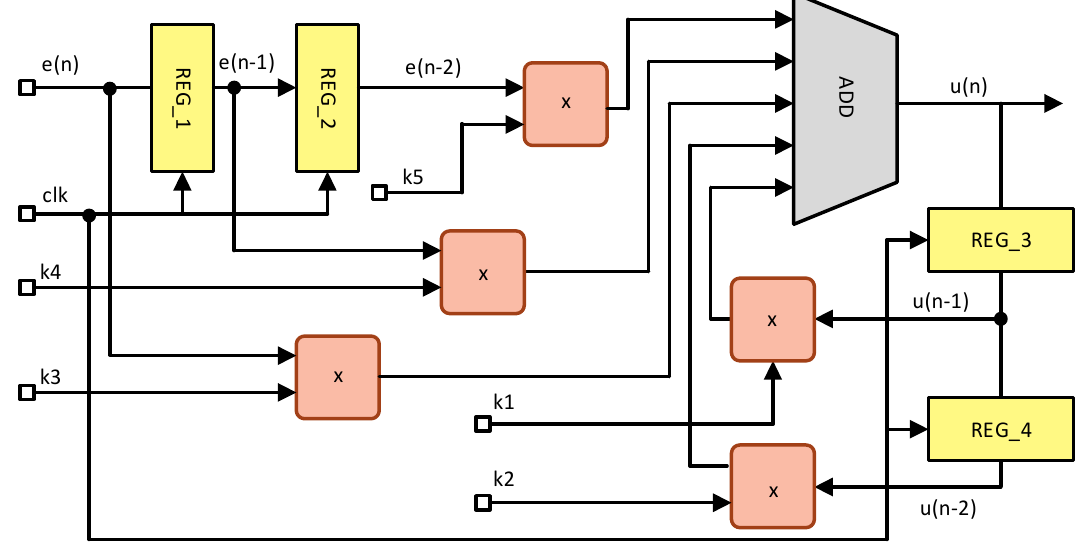
Figure 5. Block diagram of a typical PID controller FPGA architecture.